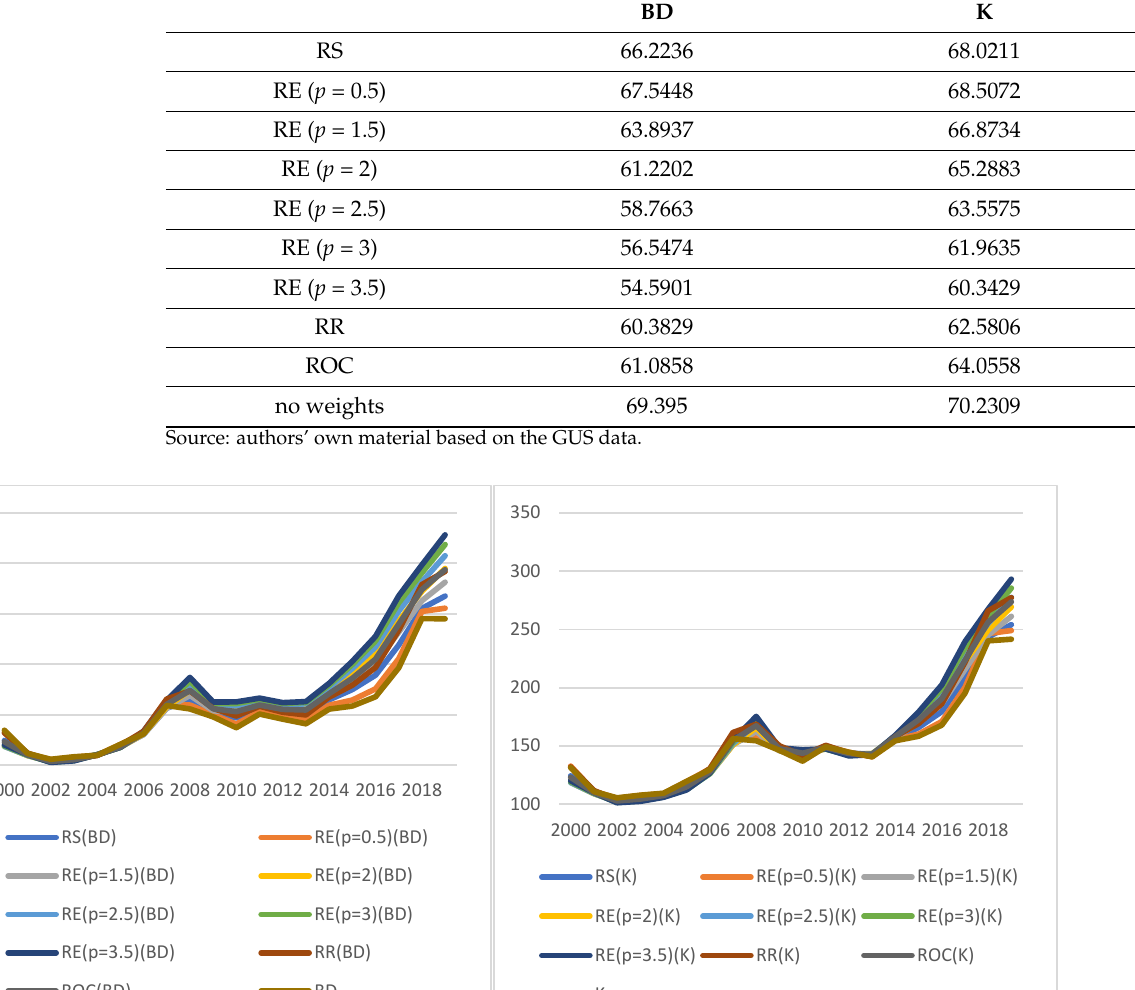
) determined by methods K and BD. best